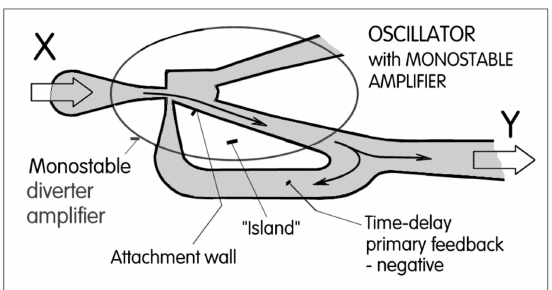
Figure 16. Simpler than the two-loop oscillator in Figure 15, this example version has a monostable amplifier and only one feedback loop. Experience shows such pulse generators to be less reliable (sometimes failing to oscillate, sometimes missing a pulse).